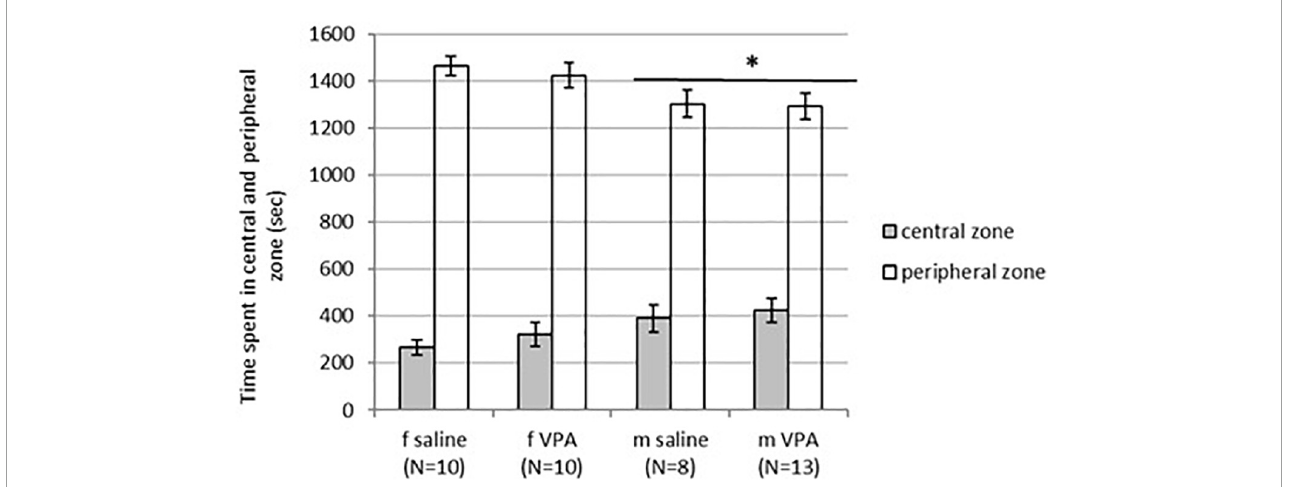
FIGURE2 Behavior of control and valproate (VPA) mice in the OFT. Males spent statistically significantly more time in the central zone ( p ∗ < 0.05) and less time in the peripheral zone ( p ∗ < 0.05) compared to females. Differences between treatments were not significant.